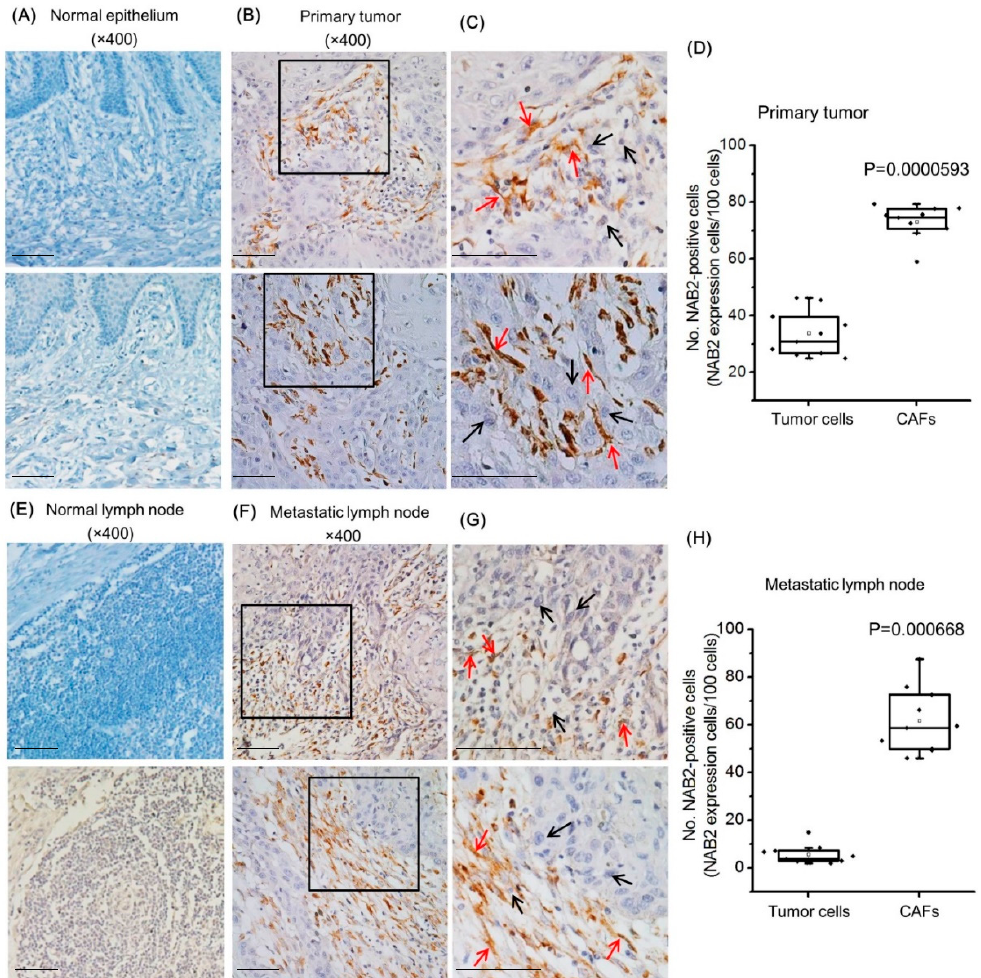
Figure 1. NAB2 expression in head and neck squamous cell carcinoma (HNSCC) patient tissues. NAB2 protein expression was compared in normal epithelial cells ( A ) and primary tumors ( B , C ), and normal lymph nodes (Scale bar in C: 100 μ M) ( E ) and paired metastatic lymph nodes ( F , G ) by immunohistochemistry. ( C ) and ( G ) are two-fold magnifications of the black rectangle images in ( B ) and ( F ), respectively. (Scale bar in G: 100 μ M) Nuclei were counterstained with hematoxylin. Red arrows indicate some representative NAB2-expressing interstitial cancer-associated fibroblasts (CAFs) of primary and metastatic lymph node tissues. Black arrows indicate NAB2-negative cancer cells. NAB2-positive tumor cells and CAFs were counted in primary tumor tissues ( D ) and metastatic lymph node tissues ( H ). The boxes show the upper 75% and lower 25% quartiles of the measurements with respect to the median value (horizontal line in each box). Each dot represents an individual patient’s data, while a small open rectangle represents the mean value. Each bar represents the standard deviation.